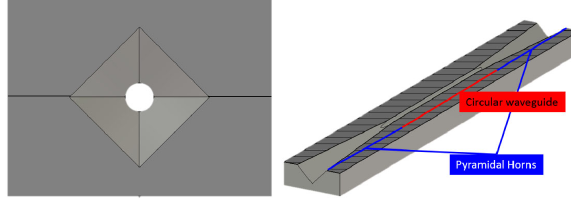
FIG. 1. DUT: circular waveguide and two pyramidal horns. Left: Front view. Right: Perspective view of longitudinal